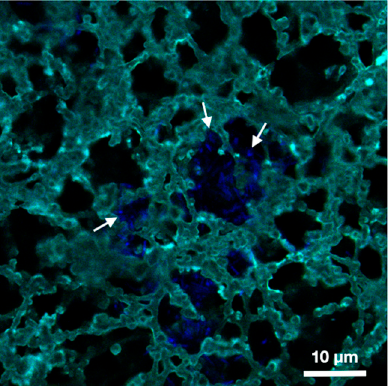
Figure 3. Confocal fluorescence microscopy image of immobilized B. thuringiensis cells (blue) in the pores of a CBD-biofunctionalized nitrocellulose membrane (turquoise). The white arrows indicate the presence of captured bacteria on the surface of the membrane pores.